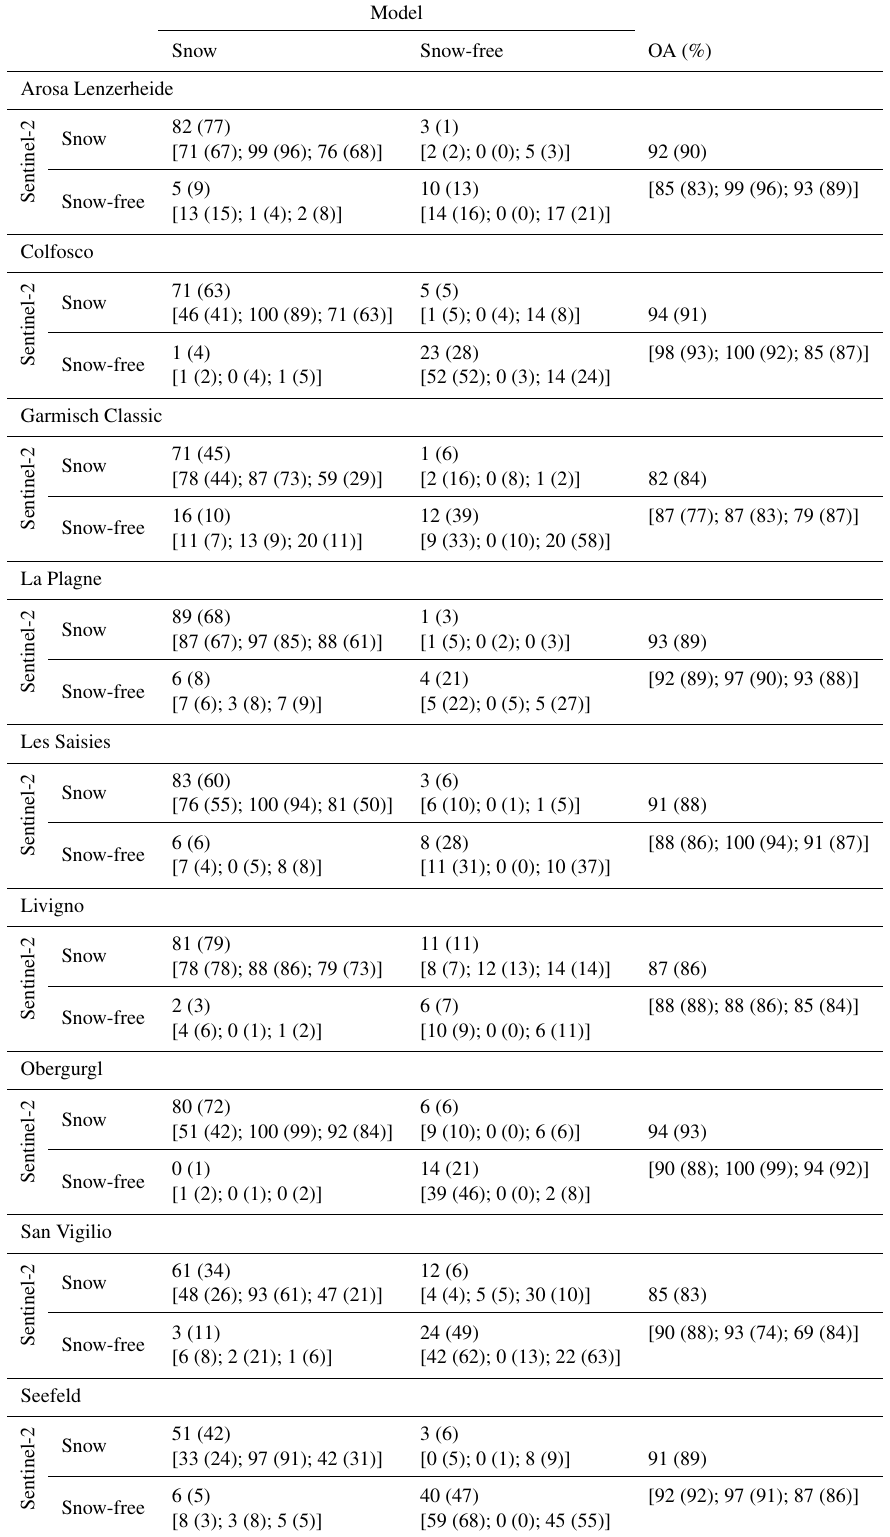
Table 3. Confusion matrix for all ski resorts referring to snow on the pistes. The values in the parentheses are referring to natural snow. The metrics in the square brackets also refer only to snow at the beginning, middle, and end of the